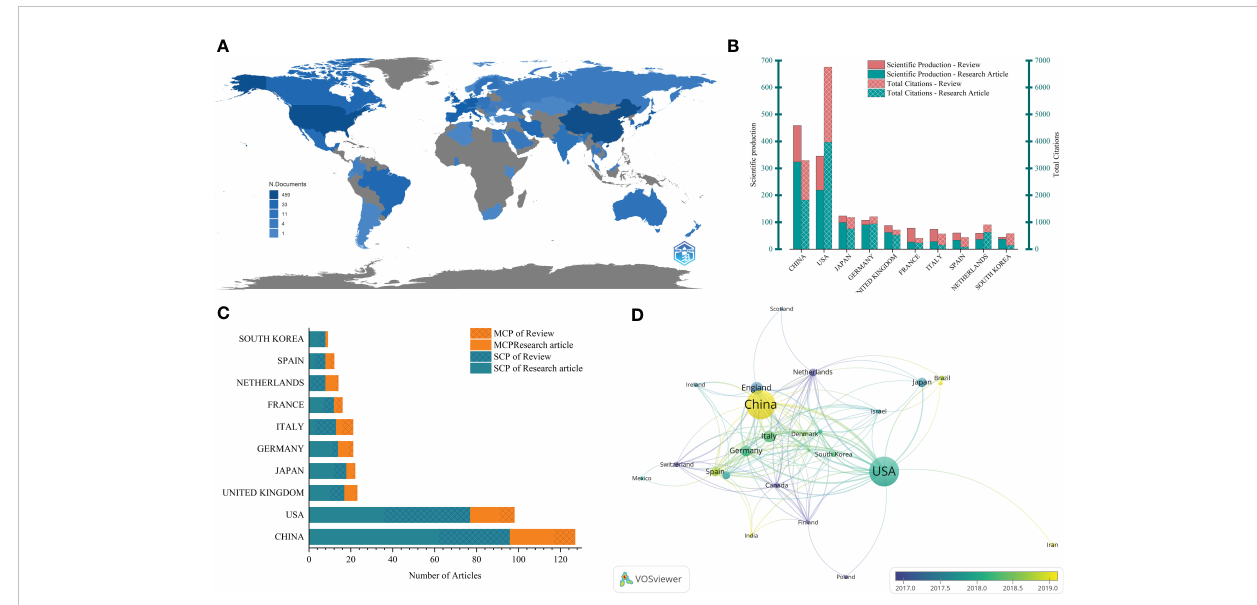
FIGURE 2 Visualization of countries/regions analysis. (A) Geographical distribution of global outputs; (B) The top 10 countries/regions in the output list and their citations (all authors included); (C) The top 10 countries/regions in output (corresponding authors included), MCP, Multiple Country Publications; SCP, Single Country Publications; (D) Cooperation networks across